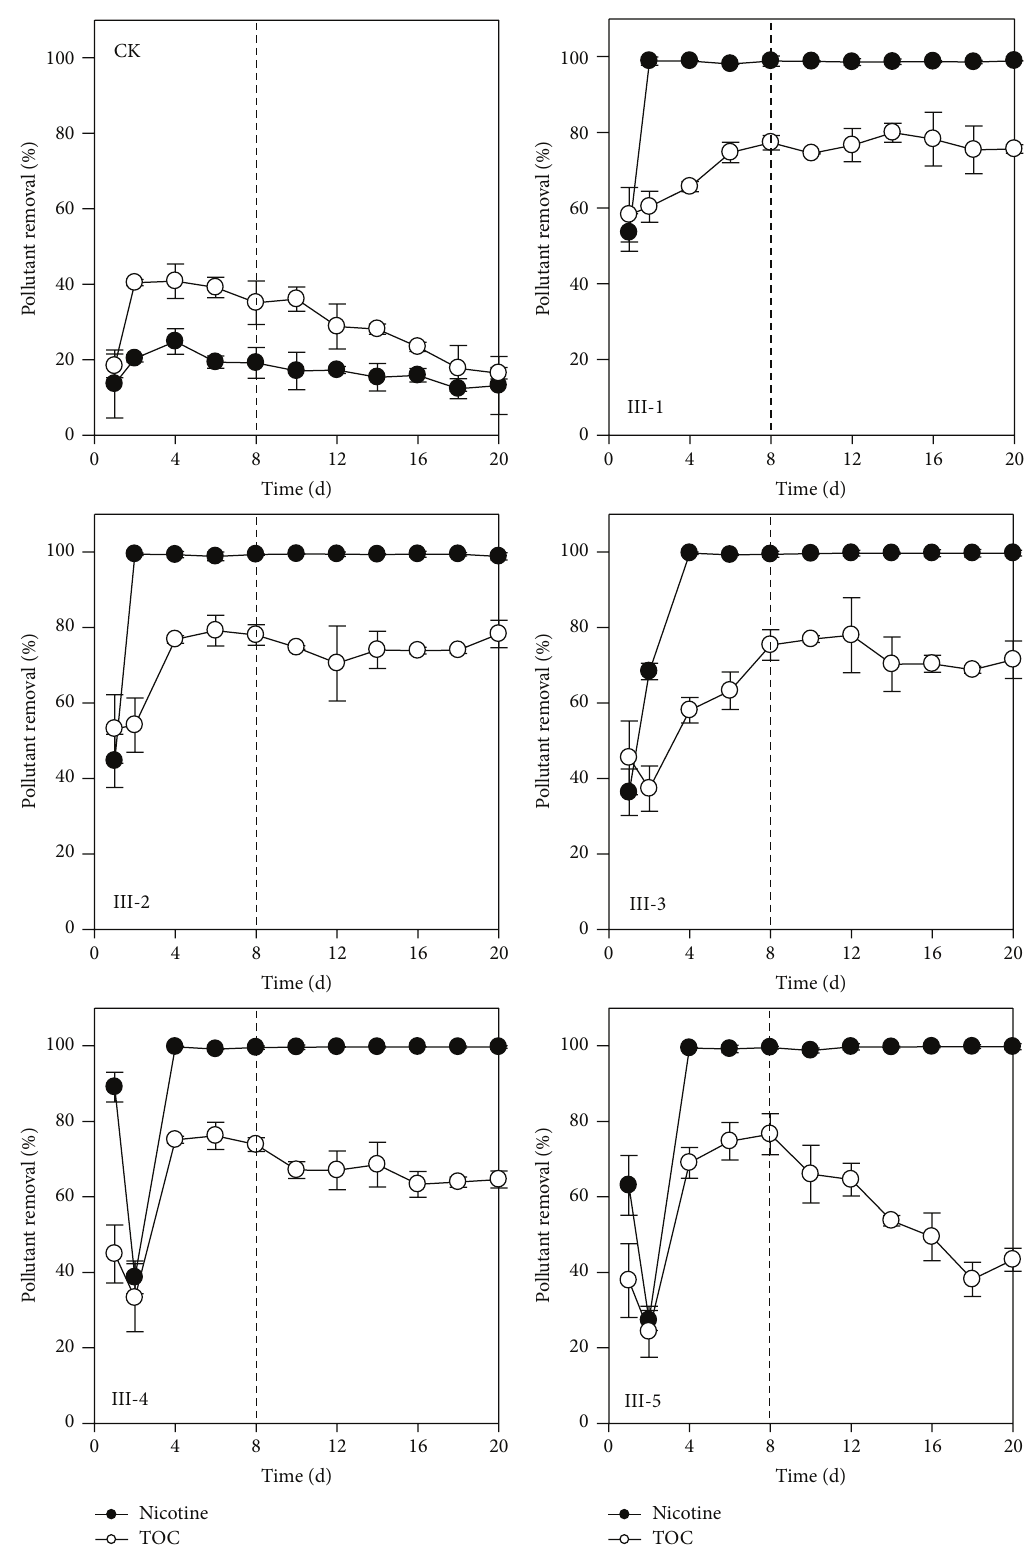
Figure 6: Effect of nicotine load on pollutant removal in tobacco wastewater. The nicotine load in reactor III-1 to III-5 was 250, 500, 800, 1000, and 1200 mg/L, respectively. CK: noninoculated